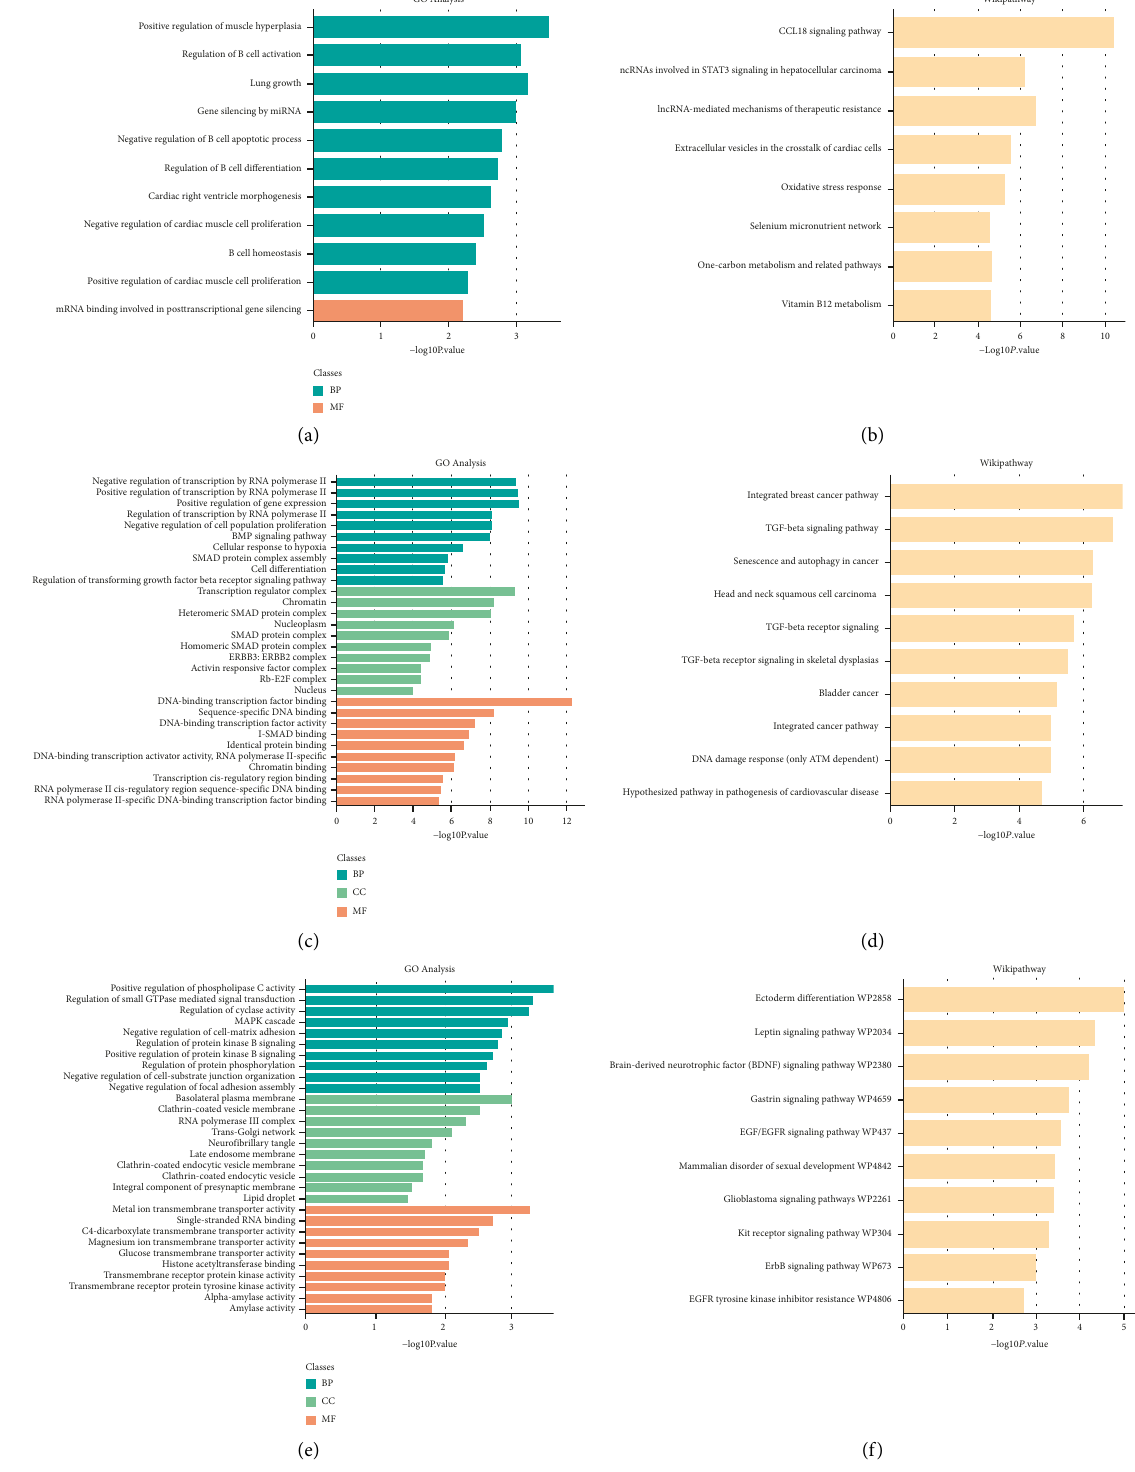
Figure 2: The GO and KEGG enrichment analyses on DElncRNAs, DEmiRNAs, and DEmRNAs. (a) The GO analysis of lncRNAs. (b) The KEGG pathway enrichment analysis of lncRNAs. (c) The GO analysis of miRNAs. (d) The KEGG pathway enrichment analysis of miRNAs. (e) The GO analysis of mRNAs. (f) The KEGG pathway enrichment analysis of